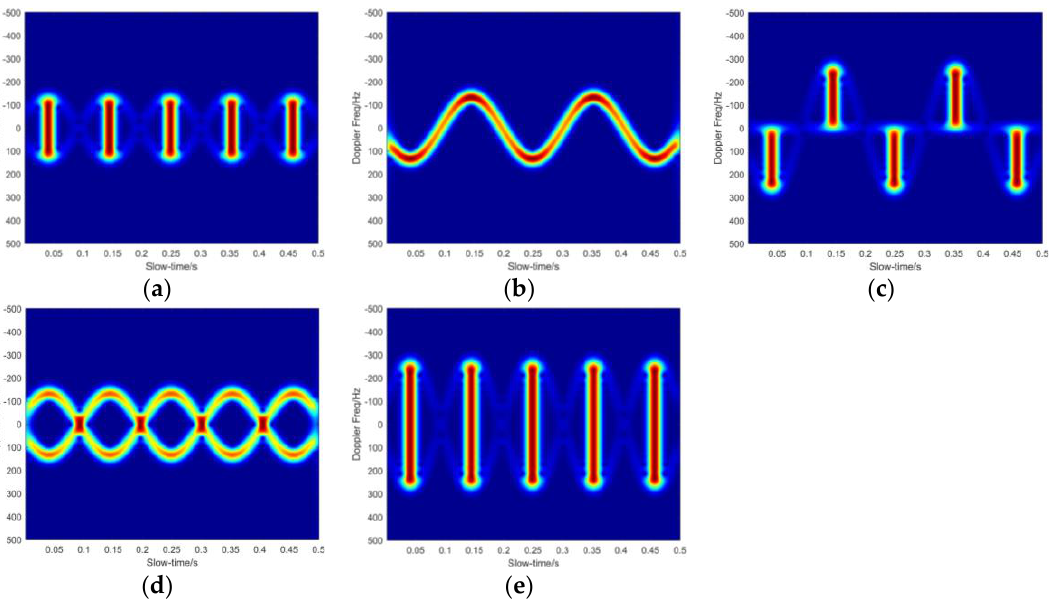
Figure 3. The STFT of a pair of symmetrical blade signals: ( a ) the profile, ( b ) the phase of the asymmetrical rotor, ( c ) the entire signal of the asymmetrical rotor, ( d ) the phase of the symmetrical rotor, and ( e ) the entire signal of the symmetrical rotor.